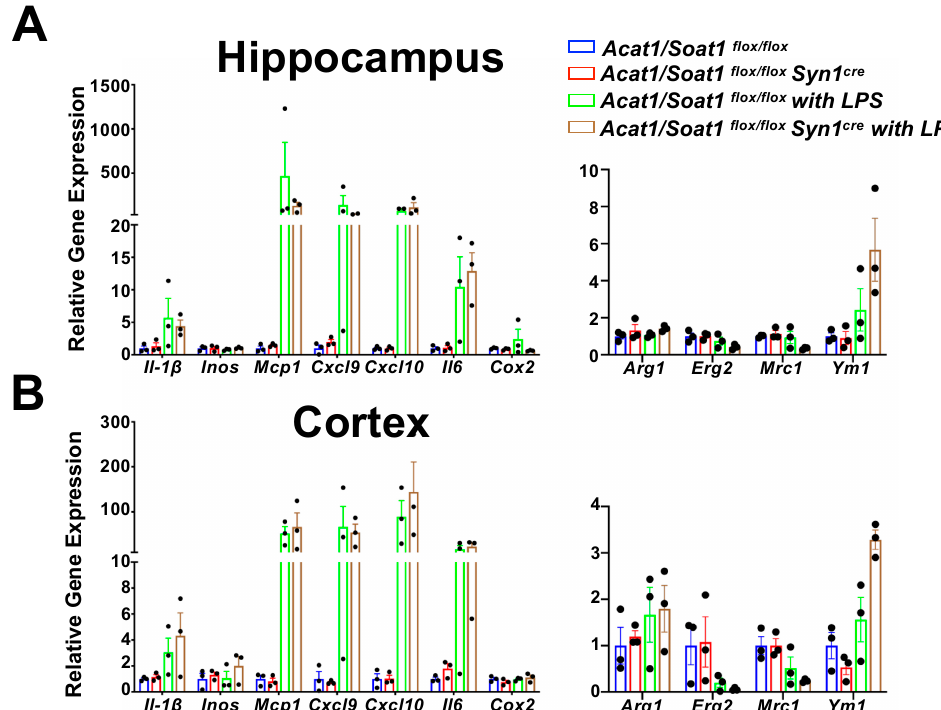
Figure 2. Neuron-specific Acat1 / Soat1 blockade did not change the inflammatory gene expression in ( A ) hippocampus and ( B ) cortex from after LPS injection. Two-month-old male Acat1 / Soat1 flox / flox mice and Acat1 / Soat1 flox / flox Syn1Cre(neuronal-cell-specific Acat1 / Soat1 knockout) mice as littermates were injected peritoneally with LPS at 5 mg/kg body weight. After 24 h, mice were sacrificed, and mRNA was extracted from hippocampus and cortex. qPCR was performed for pro-inflammatory (left panel) or anti-inflammatory (right panel) gene expression. n = 3 mice.